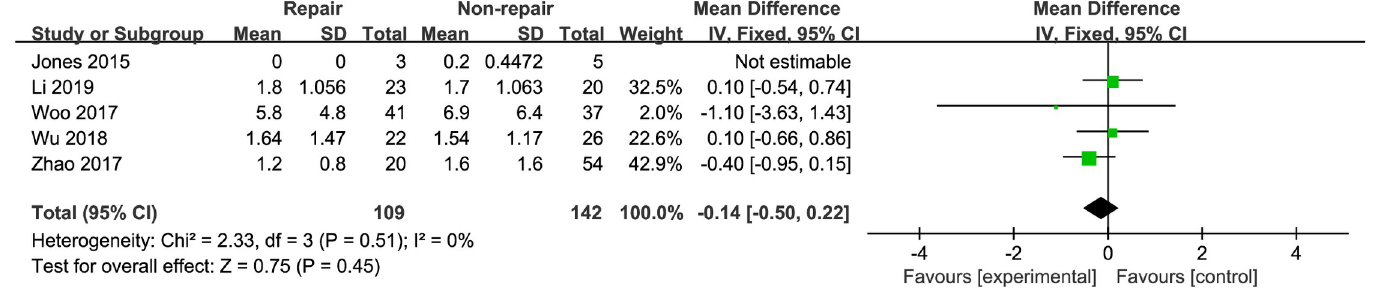
Fig 8. The forest plot of pain score.